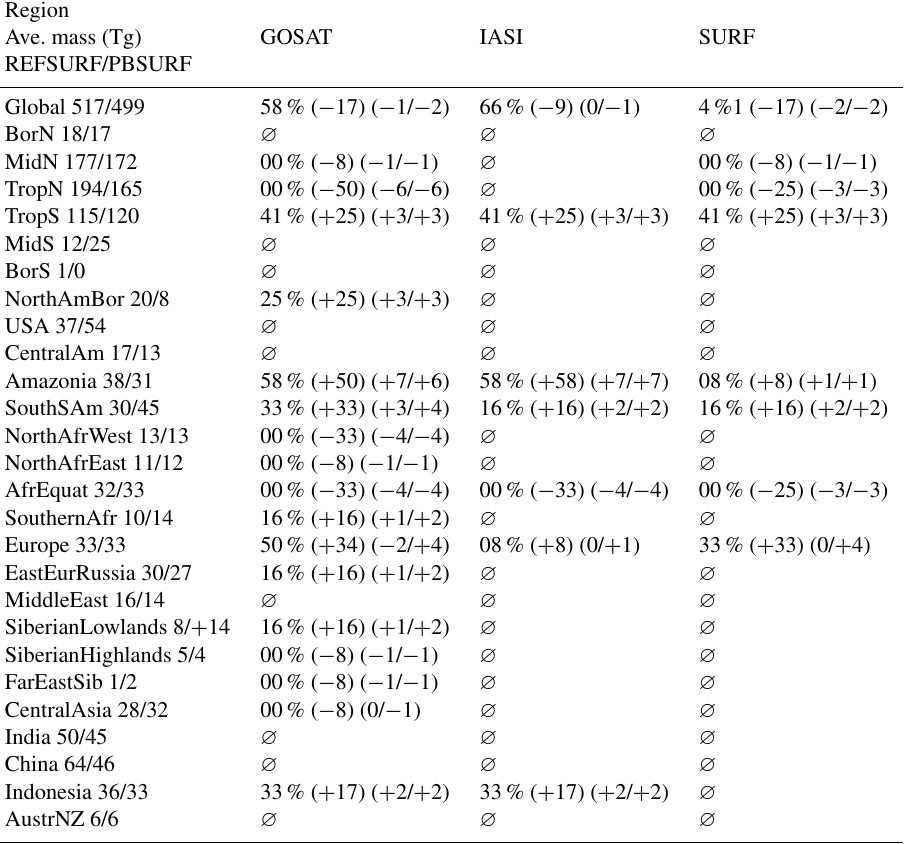
Table A3. Detection of the signal consisting in the anomalies at the yearly timescale. The signal is the difference between each year in the 2000–2011 period (i.e., 12 occurrences) and the 2004–2005 average from PBSURF. The noise is computed at the yearly timescale from each of the three observation systems, GOSAT, IASI and SURF. See Sects. 2.4 and 2.3 for details. In each cell of the table, we show X % ( ± T T ) ( ± YY/ ± ZZ ) where X % is the percentage of yearly anomalies detected, ( ± T T ) is the difference with REFSURF (Table 2), ± YY is the difference in the number of positive anomalies detected compared to REFSURF and ± ZZ is the difference in the total number of detected anomalies compared to REFSURF. Ave. mass indicates average emitted mass of CH 4 over